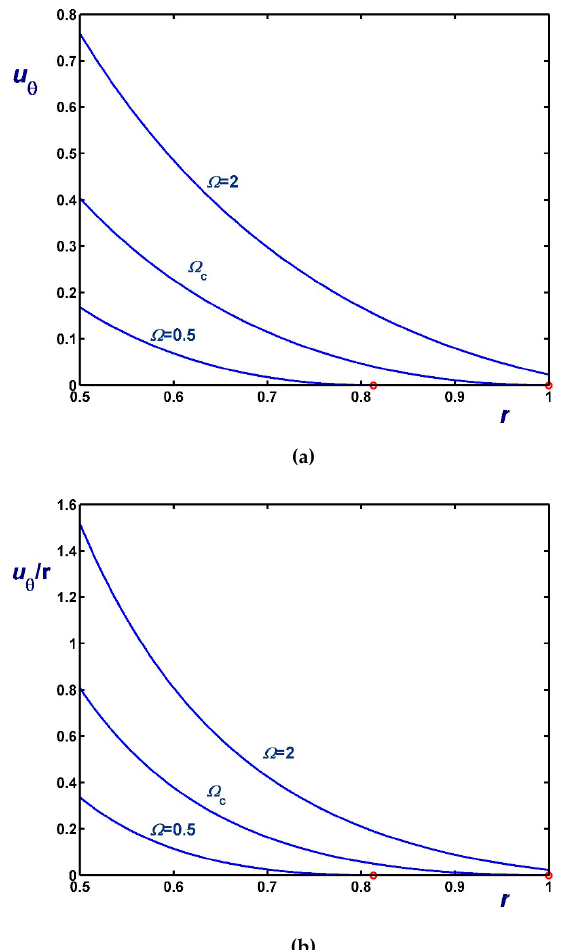
Figure 12. Velocity profiles in circular Couette flow of a Bingham plastic with non-zero slip yield stress τ ∗ c = τ ∗ , κ = 0.5 and B 1 = B 2 = 0.1 (moderate slip); ( a ) azimuthal velocity; ( b ) angular velocity; Ω c = 1.10685. The red circles indicate the yield points for the velocity profiles corresponding to Regime I.